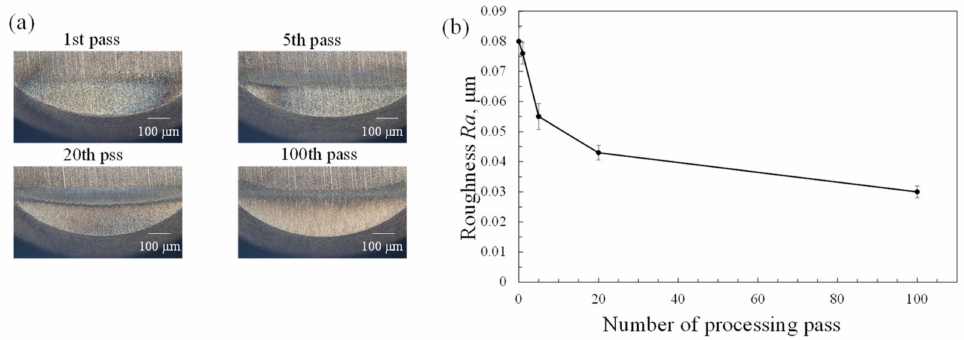
Figure 6. Evolution of the PLG-processed surface of different processing pass numbers for PLG at a pulse pitch of 2 µ m. ( a ) Optical microscope images of the PLG surfaces. ( b ) Roughness Ra of the middle part of the PLG-processed area parallel to the laser-scanning direction.